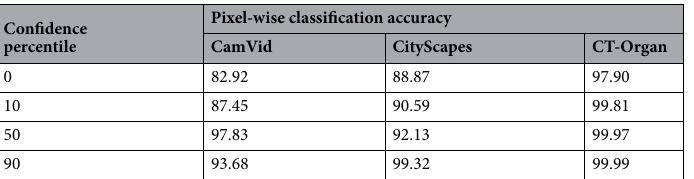
Table 3. Pixel-wise accuracy of the Bayesian frameworks as a function of confidence for the 0th percentile (all pixels) through to the 90th percentile (10% most certain pixels). This shows that the estimated model uncertainty is an effective measure of prediction